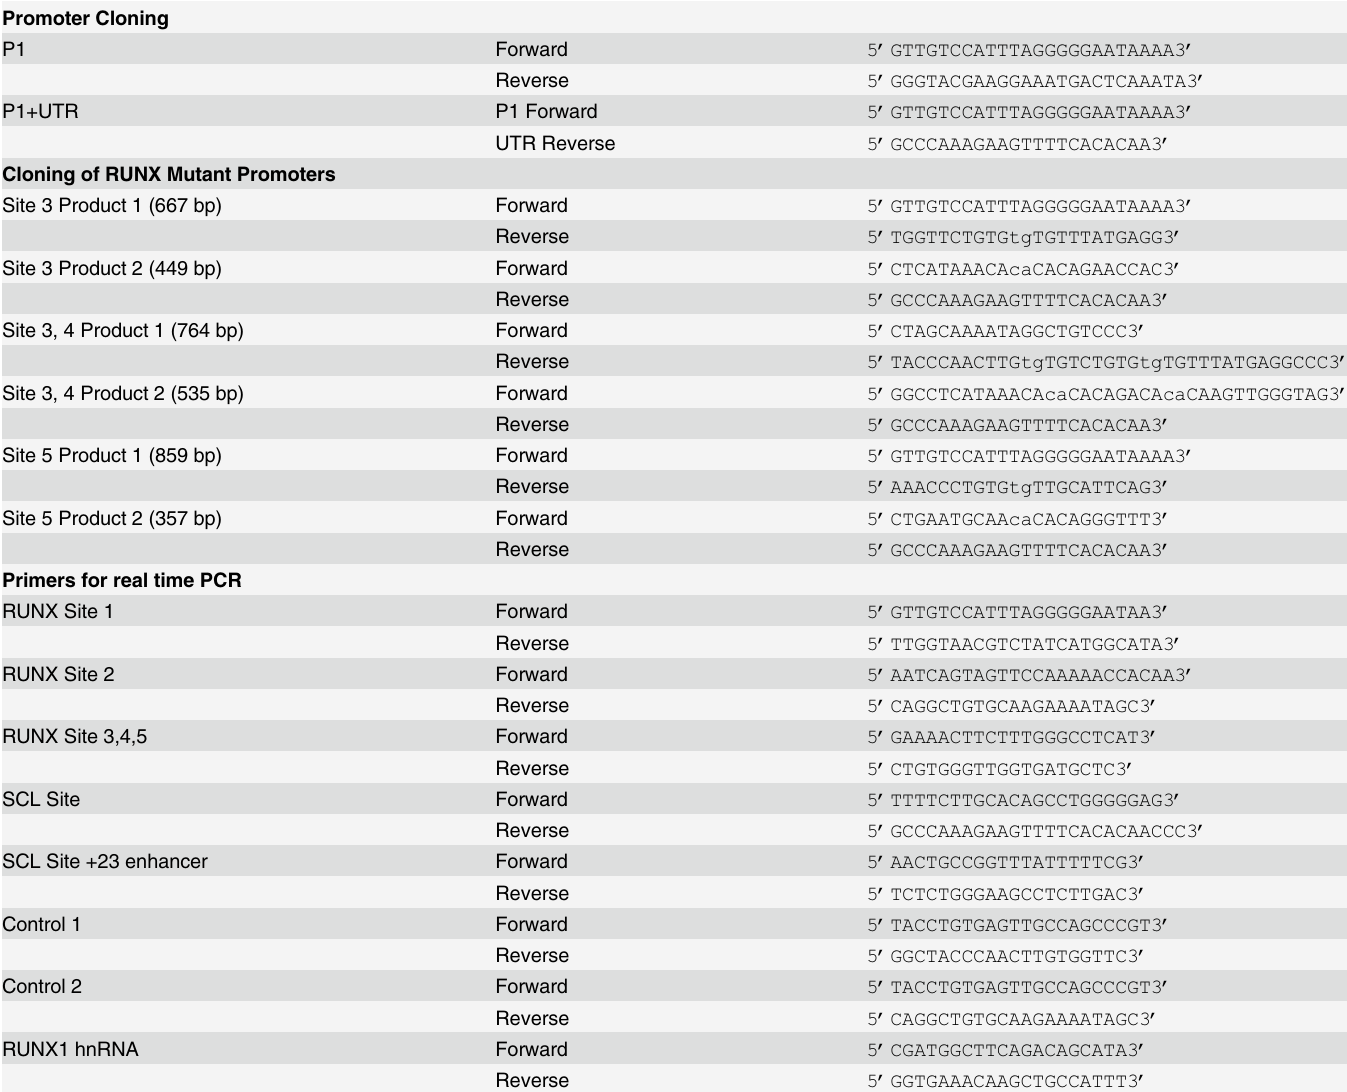
Table 1. List of